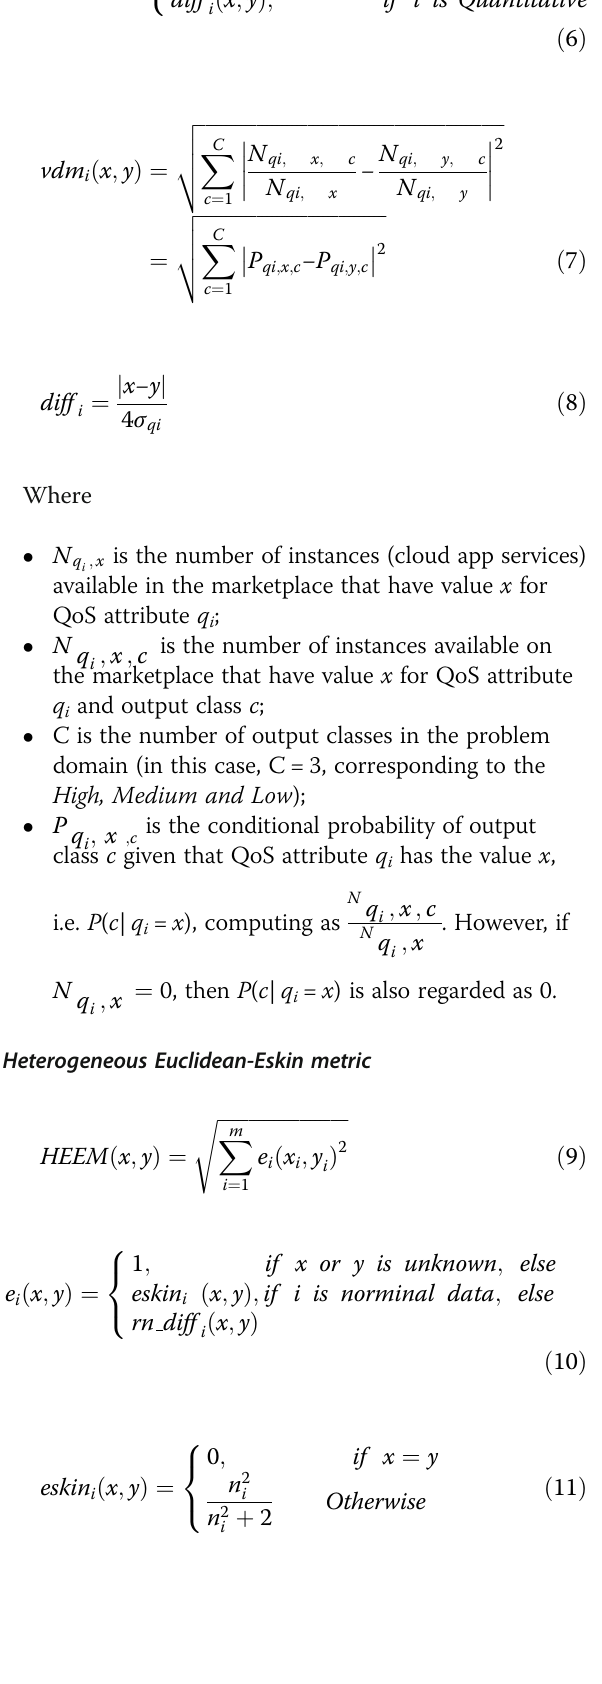
ffiffiffiffiffiffiffiffiffiffiffiffiffiffiffiffiffiffiffiffiffiffiffiffiffi X